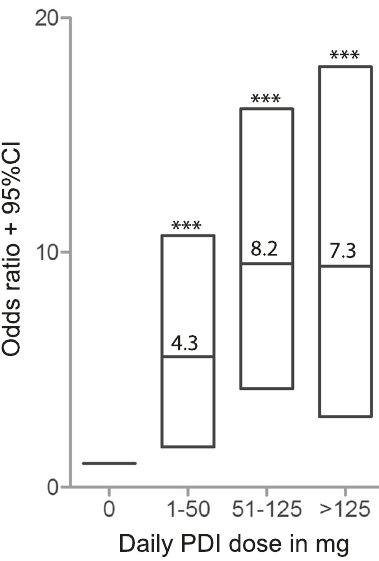
Fig. 2 Likelihood of increased serum AADC. The likelihood of elevated serum AADC increases with daily levodopa/PDI dose. Odds ratios and 95% CI for elevated serum AADC enzyme activity (>79 mU/L) are shown per category of daily PDI dose (levodopa/ PDI formulations are 4:1), analyzed with multiple logistic regression adjusted for age, gender, disease duration, and diagnosis.